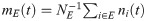
A Time-varying mean activity of the excitatory population mE(t)=NE−1∑i∈Eni(t) in a balanced EI-network (parameters given in Table 1). Thin gray lines are the outcomes of three independent simulations, the solid black line indicates the mean activity predicted by the theory (Eqs (7) and (8)). Dashed black lines indicate the range of expected fluctuations of the population activity (± one standard deviation): The square of the fluctuation magnitude is given by the variance of the population activity aENE+cEE (Eqs (3) and (4)). B Population-averaged cross covariance cEE=1NE(NE−1)∑i≠j∈Ecij
.